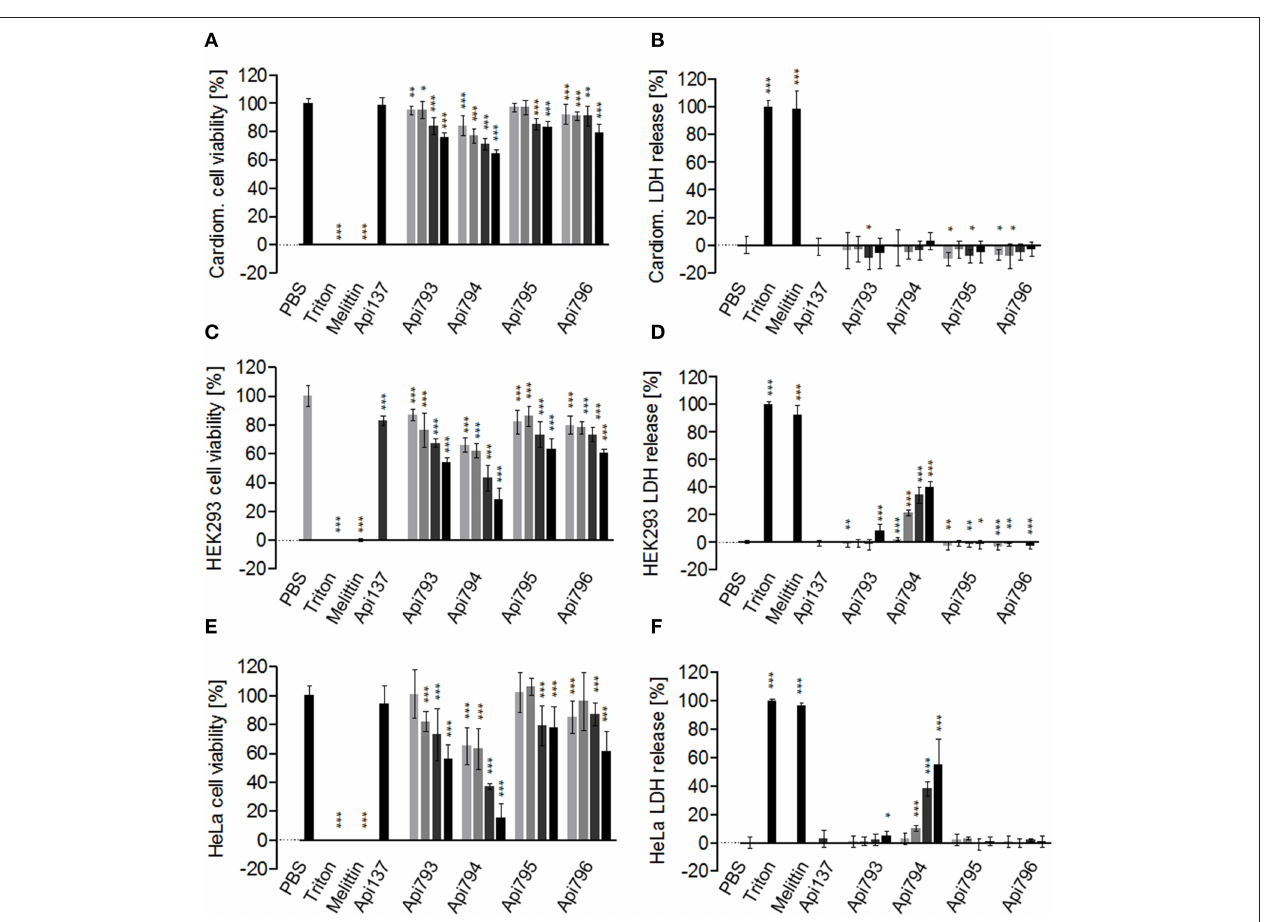
FIGURE 1 | Cytotoxic effects of Api137 studied for rat cardiomyocytes (A,B), HEK293 (C,D), and HeLa (E,F) cell lines. Cells were incubated with peptide concentrations of 0.075, 0.15, 0.3, and 0.6 g/L (light gray to black) for 24 h. Cell viability was determined in an MTT assay and cell membrane permeabilization in a LDH assay. PBS (0% LDH release and 100% cell viability, respectively) and 1% triton X100 (100% LDH release and 0% cell viability, respectively) were used as controls. The lytic peptide melittin (0.06 g/L) served as positive control. For statistical analysis, the unpaired t -test was used. *** P ≤ 0.001; ** P ≤ 0.01; * P ≤